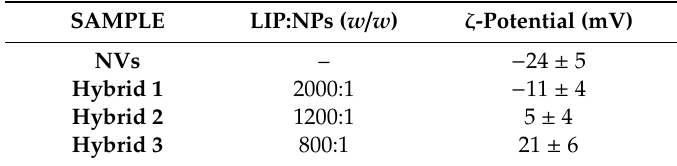
Table 2. Comparison of ζ -potential results obtained by laser Doppler velocimetry for the empty NVs and non-filtered hybrids with three increasing concentration of Cu@BDHAC.